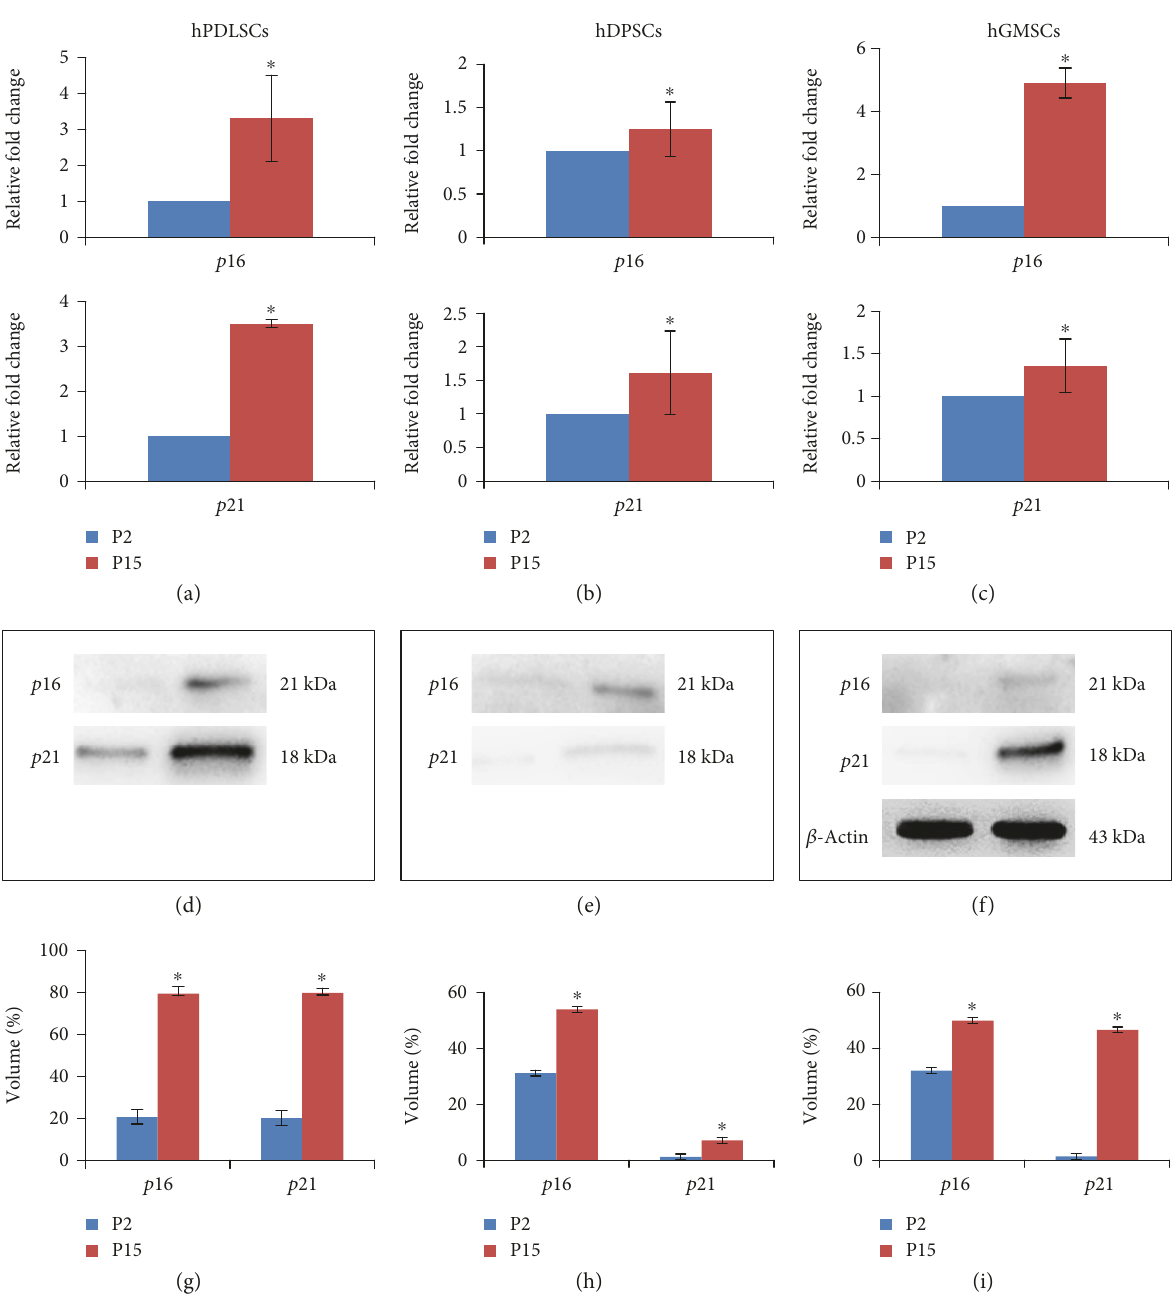
Figure 4: Characterization of early and late passages. (a) qRT-PCR for p16 and p21 . The relative fold changes represent di ff erences in gene expression at P15 compared to P2 in hPDLSCs. p16 and p21 gene expressions showed a statistically signi fi cant di ff erence at passage 15 ( p < 0 05 ). (d) p16 and p21 protein expressions at P2 and P15 hPDLSCs were validated by means of Western blotting analysis. (b) The relative fold changes represent di ff erences in gene expression at P15 compared to P2 in hDPSCs. p16 and p21 gene expressions showed a statistically signi fi cant di ff erence at passage 15 when compared to P2 ( p < 0 05 ). (e) Western blotting analysis of p16 and p21 validated gene expression pro fi le at P2 and P15 of hDPSCs. (c) The relative fold changes represent di ff erences in gene expression at P15 compared to P2 in hGMSCs. p16 and p21 gene expressions showed a statistical signi fi cance at passage 15 ( p < 0 05 ). (f) Western blotting analysis of p16 and p21 at P2 and P15 hGMSCs con fi rmed gene expression analyses. (g, h, and i) Densitometric analysis of bands related to p16 and p21 at P2 and P15 in hPDLSCs, hDPSCs, and hGMSCs ( p < 0 05 ). Statistical analyses were performed using one-way ANOVA and Bonferroni post hoc